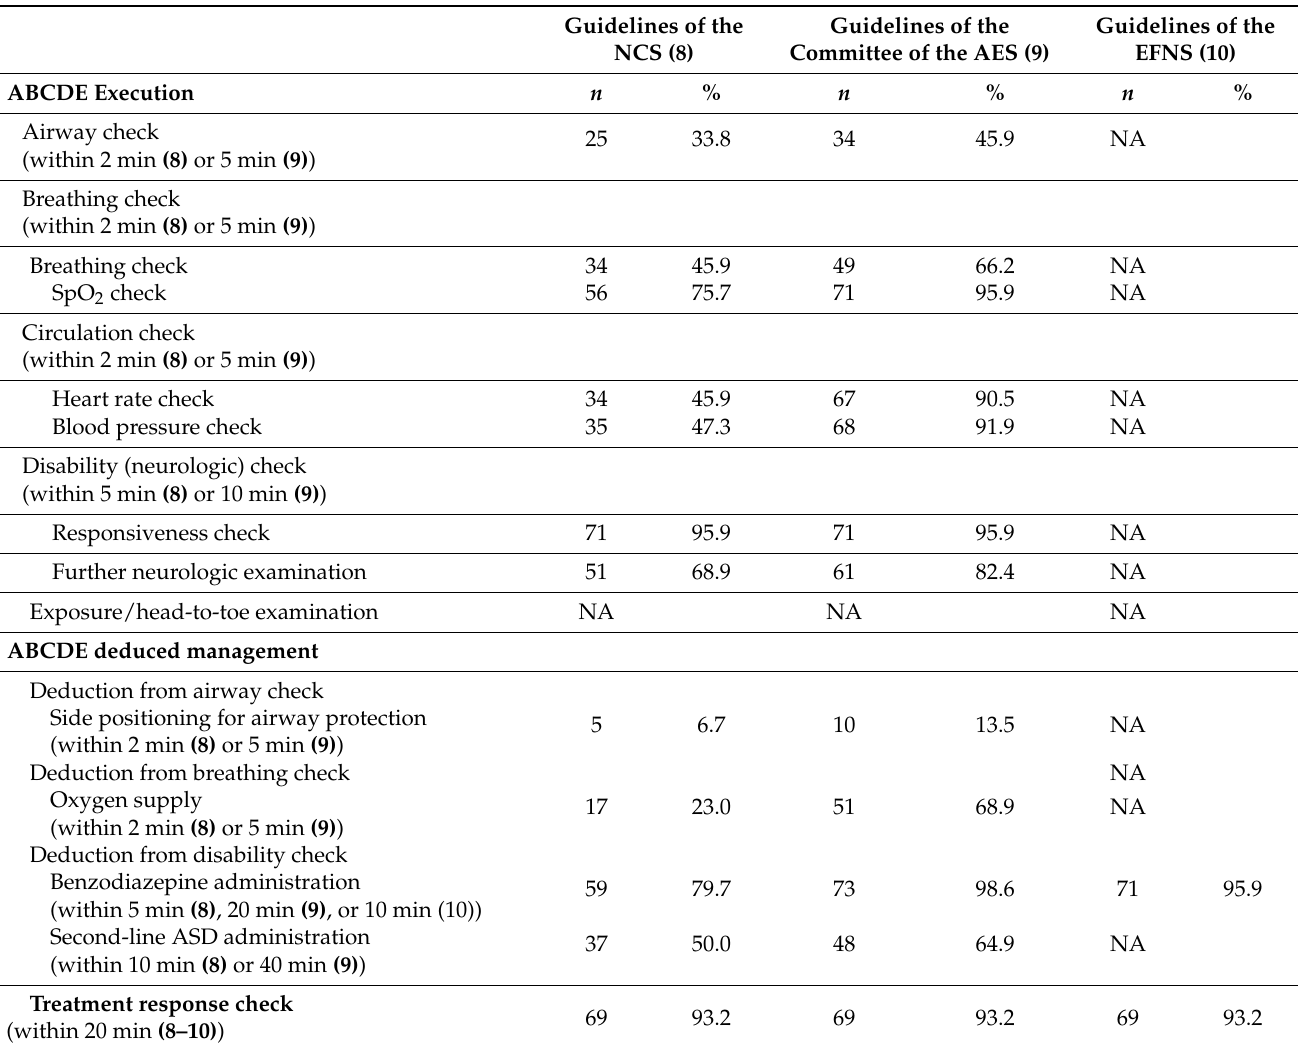
Table 2. Adherence to guidelines during treatment of patients in status epilepticus. SpO 2 = pe- ripheral capillary oxygen saturation of the blood; SE = status epilepticus; ASD = antiseizure drug; NA = not applicable due to no or unspecific recommendation. NCS = Neurocritical Care Society, AES = American Epilepsy Society, EFNS = European Federation of Neurological